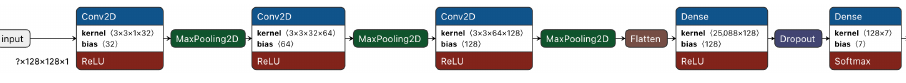
Figure 1. The convolutional neural network.